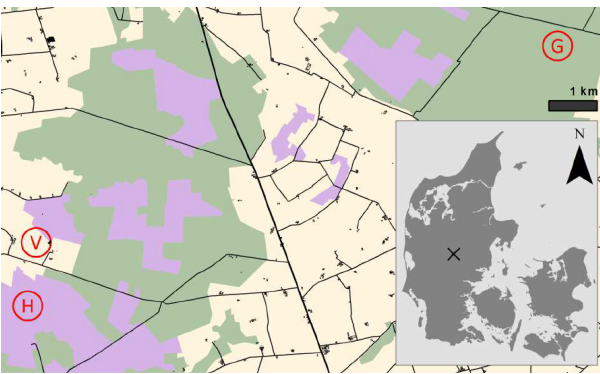
Figure 1. Map showing the location of the three field sites; G: Glud- sted plantation, V: Voulund farmland, and H: Harrild heathland. The circles represent the footprint of the neutron detector (ra- dius = 300m). Green color corresponds to forest, beige to agricul- ture and purple to